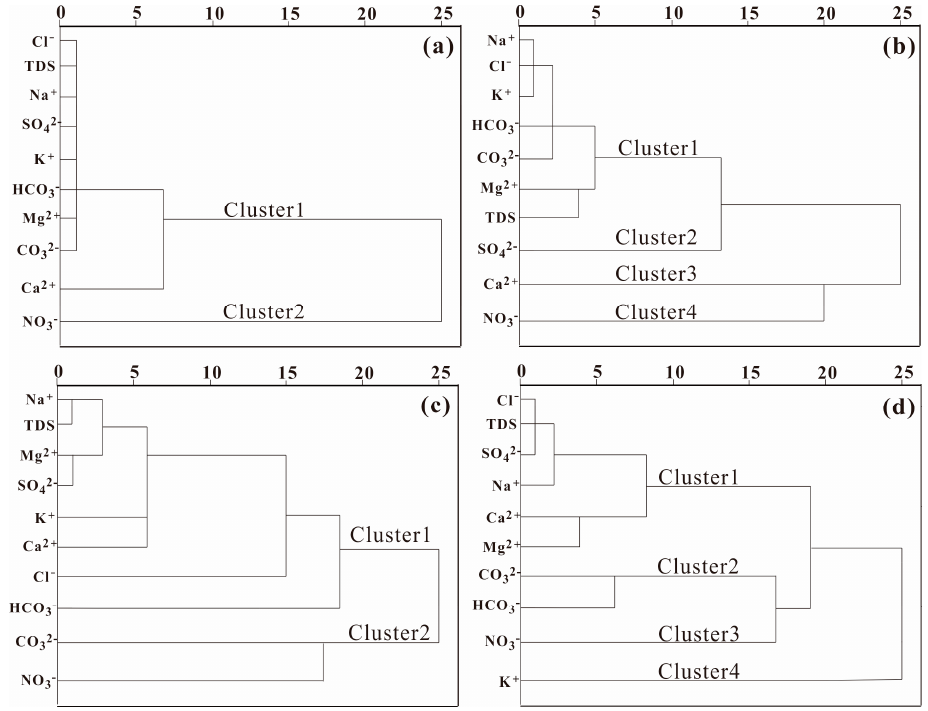
Figure 5. Hierarchical cluster analysis of the water bodies in Hulun Lake Basin in different seasons: ( a ) lake water in the non-frozen season; ( b ) lake water in the frozen season; ( c ) groundwater in the non-frozen season; ( d ) groundwater in the frozen season.